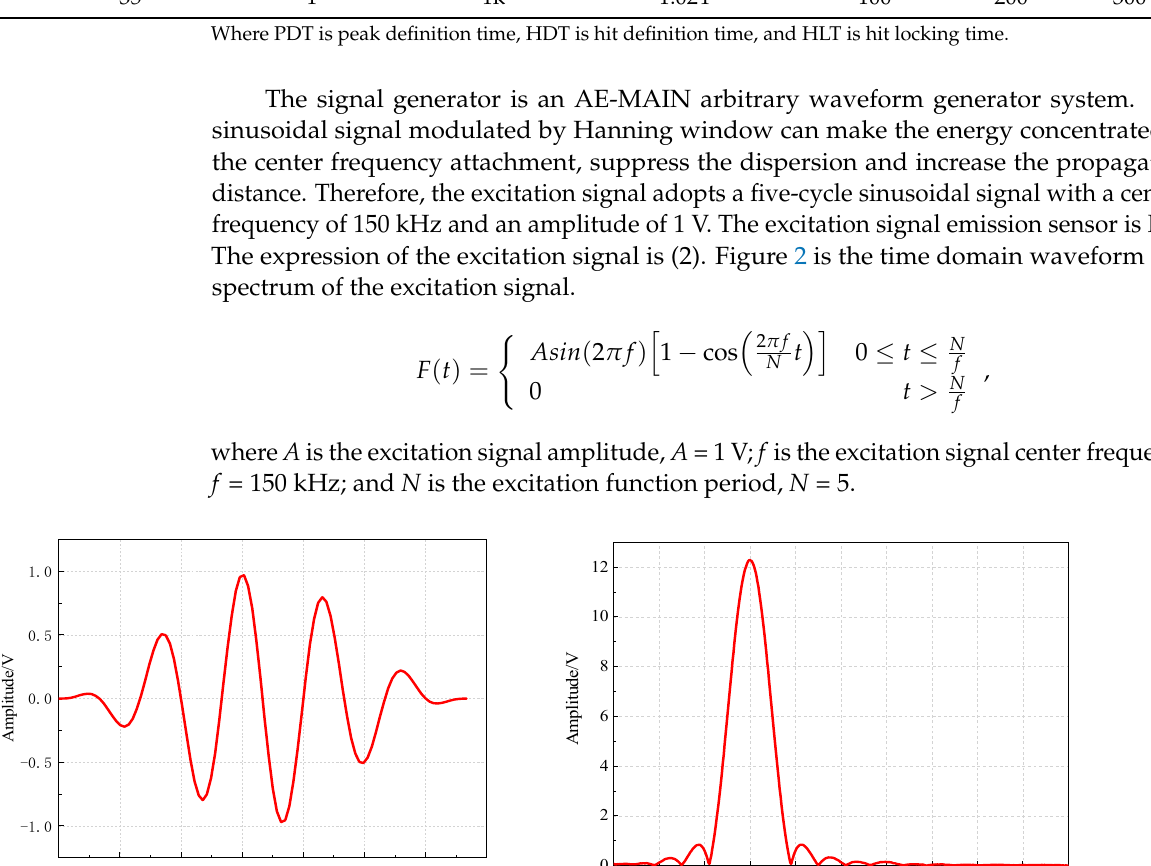
Table 2. Parameters setting of acoustic emission acquisition.